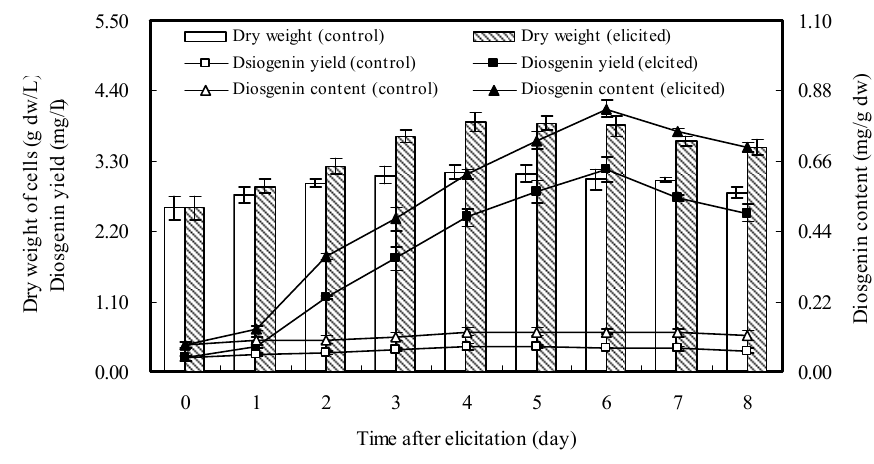
Figure 3. Time courses of growth and diosgenin accumulation of D. zingiberensis cell cultures treated once with DP7 added on day 26 at 6 mg/L. The error bars represent standard deviations ( n =